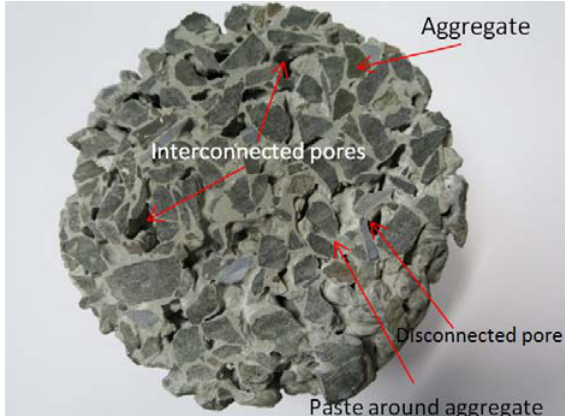
Figure 1. Cross ‐ section of PCPC, illustrating porous